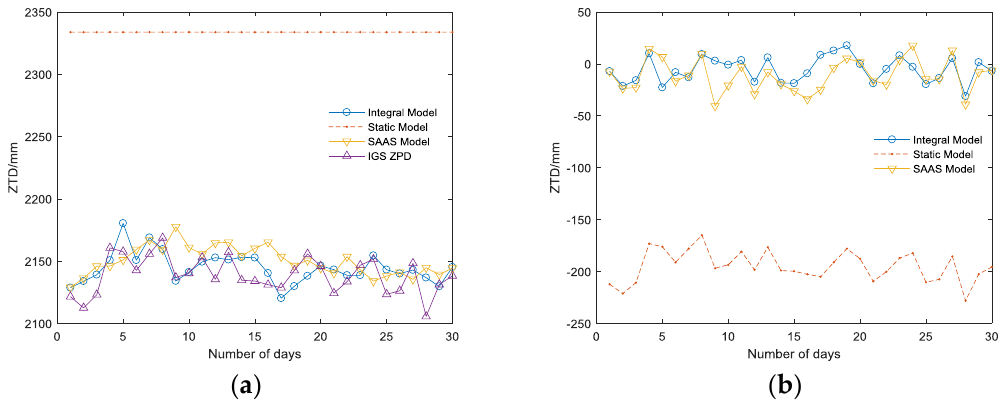
Figure 6. ( a ) The URUM IGS ZPD variations and ZTD variations of the three models in December ( b ) The DIFF between ZTD of three models and the URUM IGS ZPD in